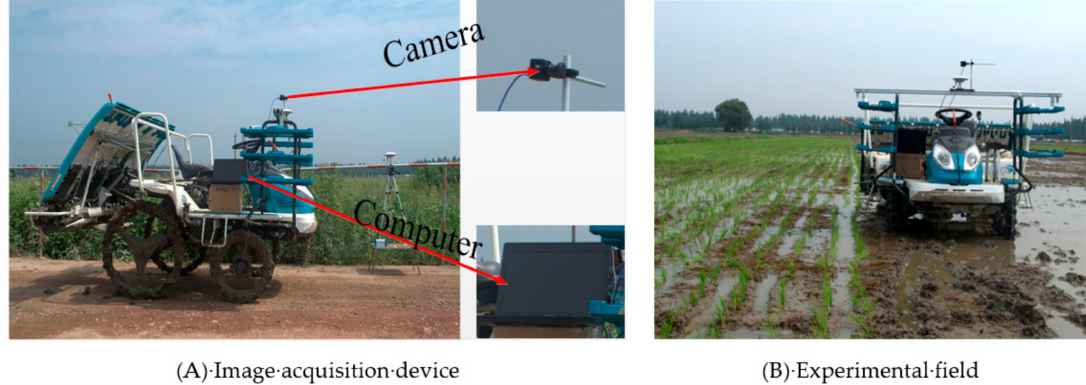
Figure 1. Image acquisition. ( A ) image acquisition device; ( B ) experimental